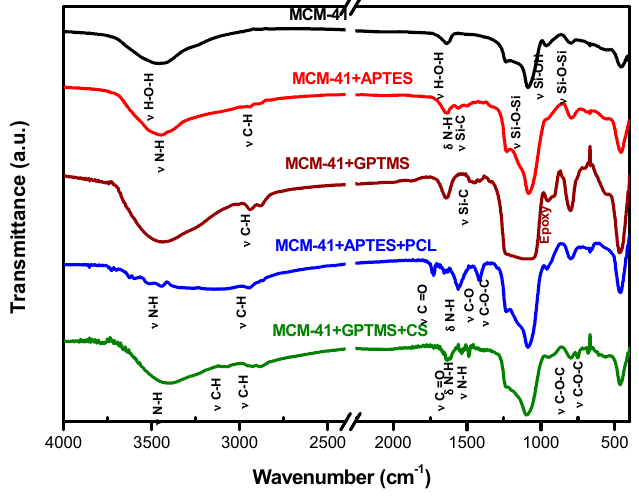
Figure 2. FTIR analysis of pure MCM-41 and modified samples with APTES-PCL and GPTMS-CS.